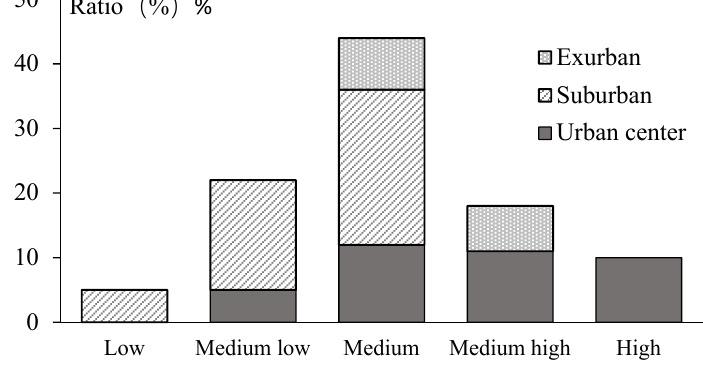
Figure 4. The proportion of SoVI scores in Nanjing.